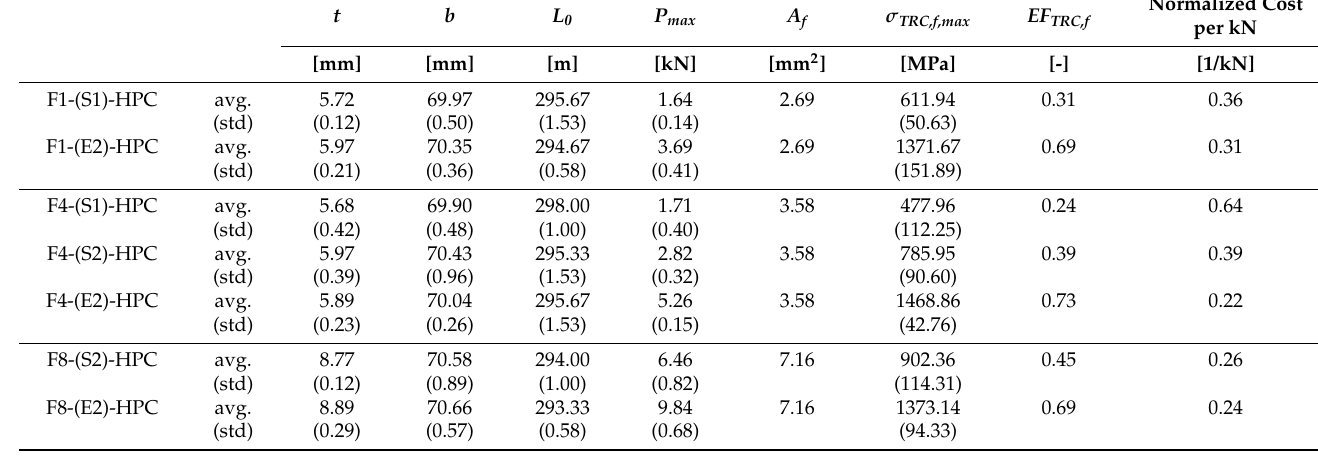
As for the plain textiles, the normalized cost per unit load was computed for the TRC Table 5. Tensile test results for TRC samples: geometry, mechanical parameters, and normalized costs per unit load. composites and is reported in Table 5. In Figure 14, those values are expressed as a func-